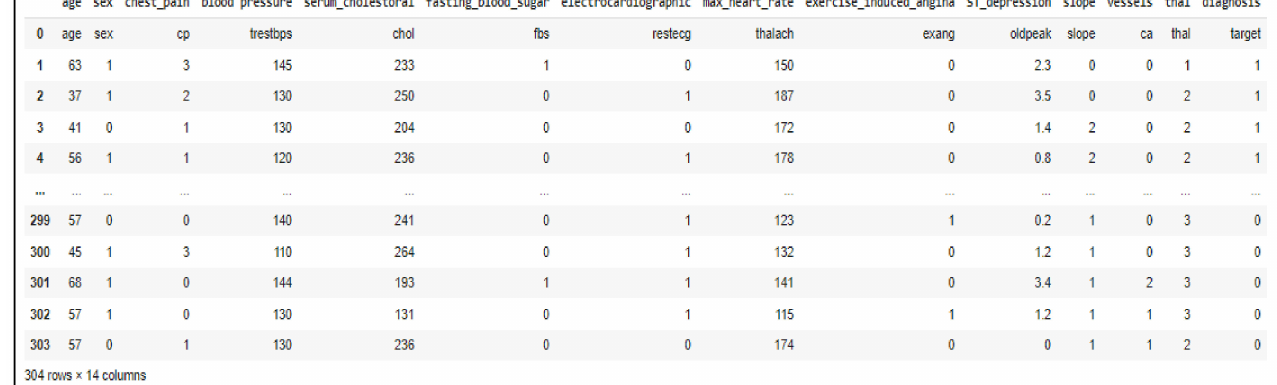
Figure 3. The UCI Heart Disease dataset.